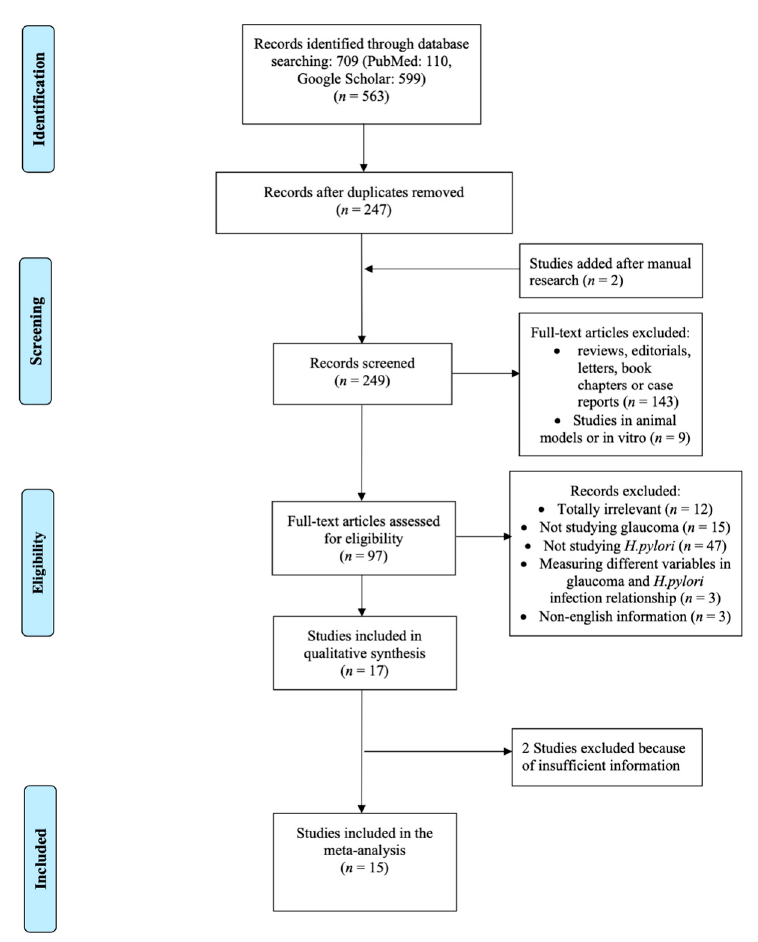
Figure 1. Flowchart based on Preferred Reporting Items for Systematic Reviews and Meta-Analyses (PRISMA) guidelines interpreting the selection process of the reviewed studies to insert in the meta-analysis.